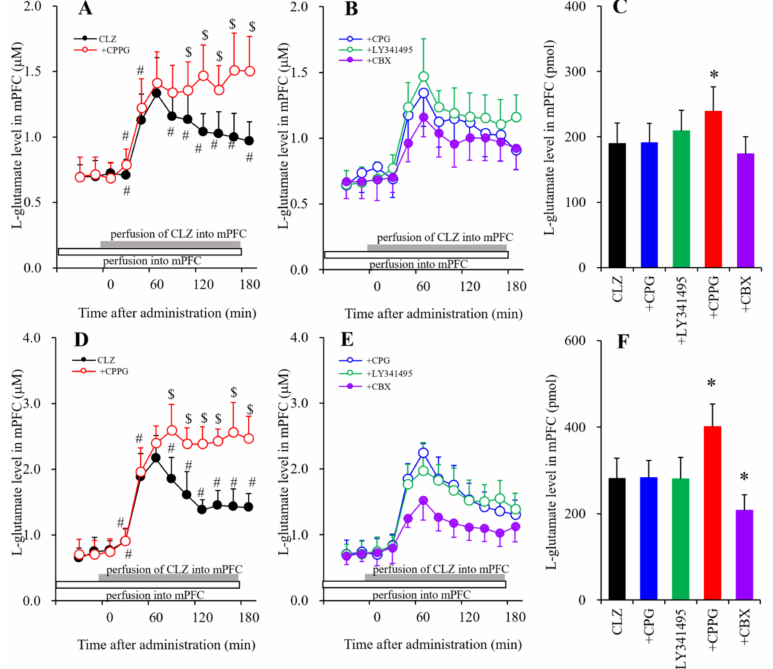
Figure 5. Interaction of perfusions with CLZ ( A – C ): 30 and ( D – F ): 100 µ M) and CPG (1 µ M), LY341495 (1 µ M), CPPG (100 µ M), and CBX (100 µ M) into the mPFC on extracellular l -glutamate levels in the mPFC. Perfusion medium in the mPFC commenced with MRS containing CPG, LY341495, CPPG, or CBX. After confirming the stabilization of extracellular l -glutamate levels, the perfusate in the mPFC was switched to the same perfusate containing CLZ (30 or 100 µ M) for 180 min. Ordinates: mean ± SD ( n = 6) of extracellular l -glutamate levels ( µ M). Abscissas: time after administration of CLZ perfusion (min). AUC values of l -glutamate levels (pmol) during perfusion with CLZ (from 20 to 180 min) based on ( A , B ) (30 µ M CLZ) and ( D , E ) (100 µ M CLZ) were indicated in Figure 5C,F, respectively. * p < 0.05. This is relative to the control (CLZ: black bar) using LME with Tukey’s post hoc test. In ( A , D ), # p < 0.05. This is relative to the l -glutamate at 60 min ( $ p < 0.05). This is relative to CLZ using LME with Tukey’s post hoc